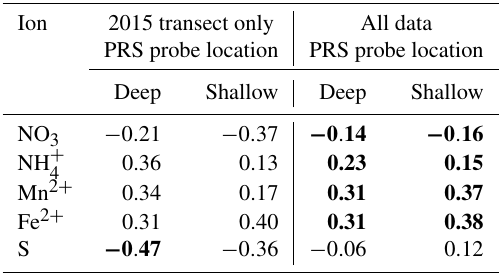
Table 5. Pearson correlation coefficients between natural logarithm- transformed CH 4 fluxes and plant root simulator (PRS) ion ex- change resin measurements. Methane fluxes were averaged over the same 1-month periods in which the PRS probes were buried, n = 25 for transect data and n = 163 for the entire study. Deep probes were buried outside the collars at 0.2m, and shallow probes were buried at 0.1m outside the collars. Significant correlations ( α = 0 . 05) are in